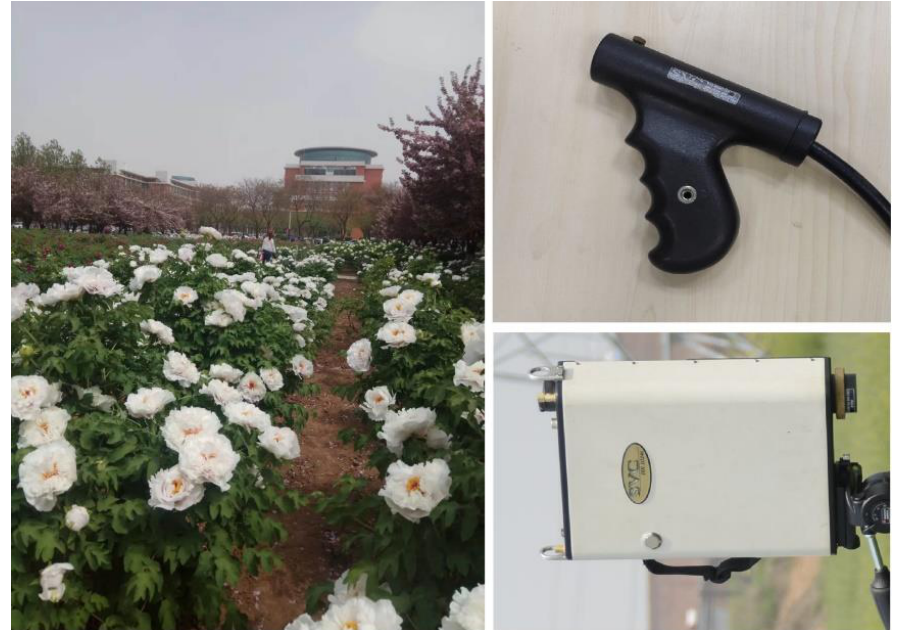
Figure 2. Spectrometer and tree peony samples.